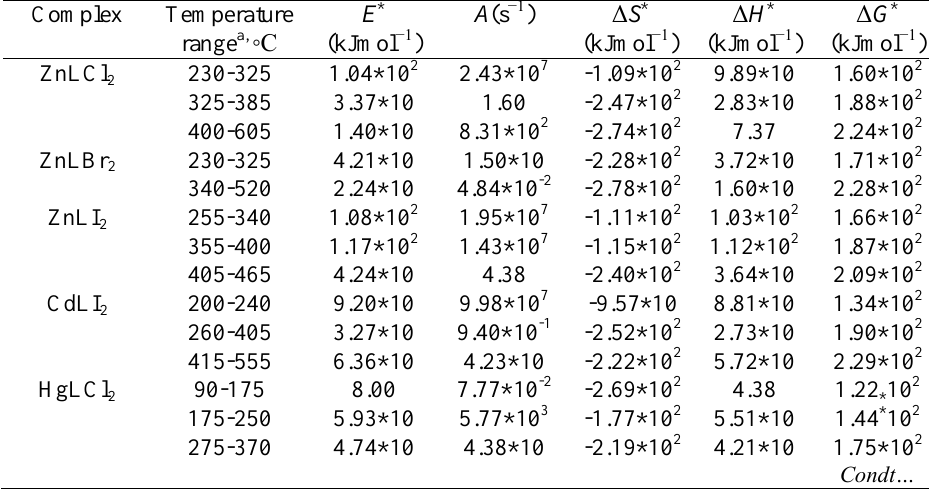
Table 3. Thermodynamic activation parameters of decomposition processes of complexes. Complex